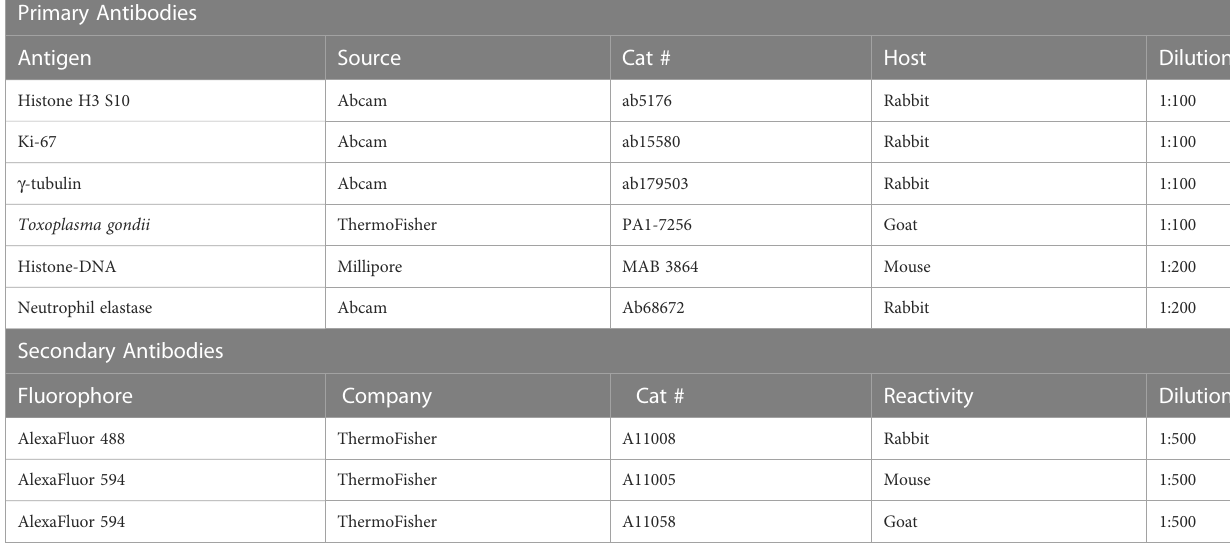
TABLE 1 Primary and secondary antibodies used for immuno fl uorescence analyses. Primary